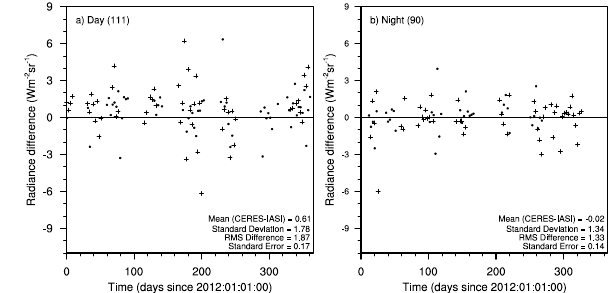
Figure 10. Time series of INLR bias at SNOs between CERES and IASI for 2012 for (a) day and (b) night. CERES measurements from Terra are marked with crosses and those from Aqua are shown as dots. Standard error is the standard deviation divided by the square root of the total number of points.